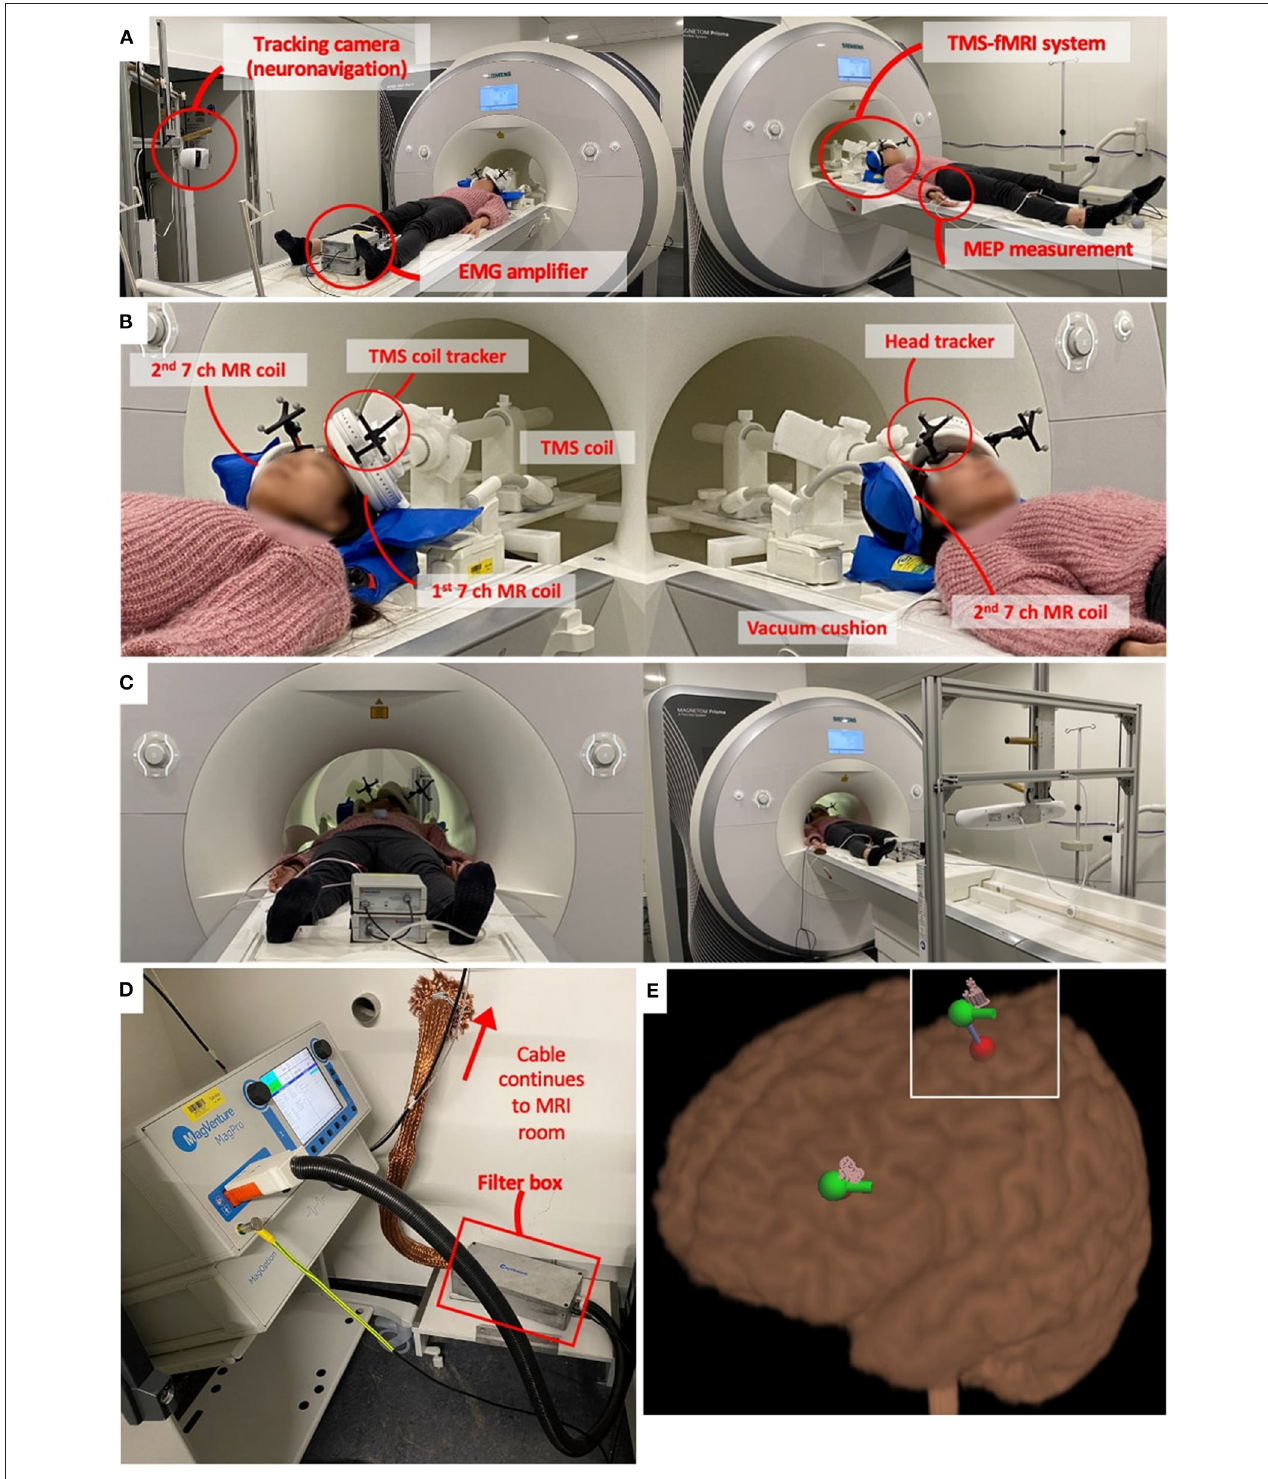
FIGURE 1 | Example of TMS-fMRI set up. (A) This particular example of TMS-fMRI set up includes MR compatible TMS coils (Magventure, Farum, Denmark), MR coils (16), neuronavigation system (Localite, Bonn, Germany), and a BrainAmp ExG MR amplifier (BrainProducts, Gilching, Germany) for electromyographic (EMG) measurements to determine motor threshold (MT). (B) TMS coil is mounted on a holder which goes in the bore of the scanner. The holder system is attached to the scanner bed so that it moves together. The MR head coil, in this example, is two thin and flat seven channel coils. One is attached below the TMS coil, and